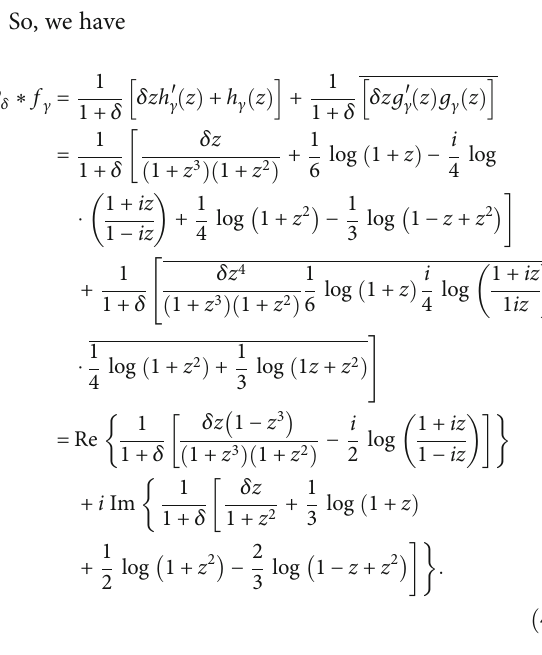
∗ f . Figure 8: Image of F − 1/4 ∗ f 2 Π /3 − 1/3 2 Π /3